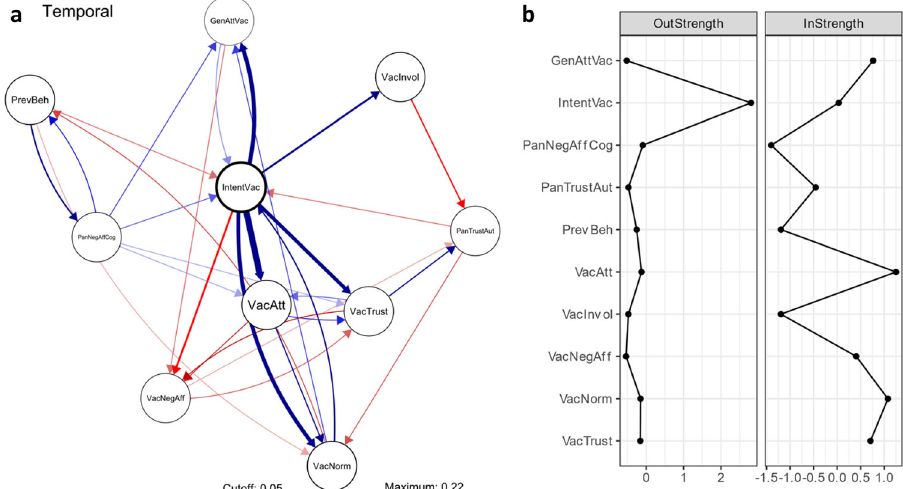
Fig. 5 Temporal broad COVID-19 vaccines network. See Fig. 4 for node legend. a Network: nodes represent measured variables with border width indicating stability. Edges indicate predictive effects for the next measurement when controlling for every other node in the network. Edge weights, as indicated by width based on the correlation coef fi cient, represent the strength of effects (see Table 2). Blue edges indicate positive (excitatory) effects and red edges indicate negative (inhibitory) effects. Edges with weights above 0.05 are plotted with a thickness corresponding to their magnitude. b Standardized node strength, which represents direct effects of speci fi c nodes in the network. InStrength refers to edges affecting that speci fi c node, and OutStrength refers to edges originating from that node and affecting other This indicates that these nodes have the highest conditional reported, on average, higher intention to get vaccinated also association with other nodes in the between-person broad reported, on average, less negative emotions related to COVID-19 COVID-19 vaccines network, thus these are highly connected to vaccines, and vice versa. other nodes in this network. The standardized centrality measure “ node strength ” for the This interindividual level analysis, however, provided no between-person broad COVID-19 vaccines networks is depicted in information on the direction of effects. The longitudinal design Fig. 4b (node strength values discussed in the text are reported in of this study also allowed for calculating within-person parentheses). The node Intention vaccine was relatively central in predictive effects between variables. This resulted in a the network (0.46), indicating that it has associations with many temporal broad COVID-19 vaccines network with directed other nodes. The nodes Vaccines attitude and Vaccines trust edges between nodes. showed the relatively highest strength (1.61, 1.21, respectively).